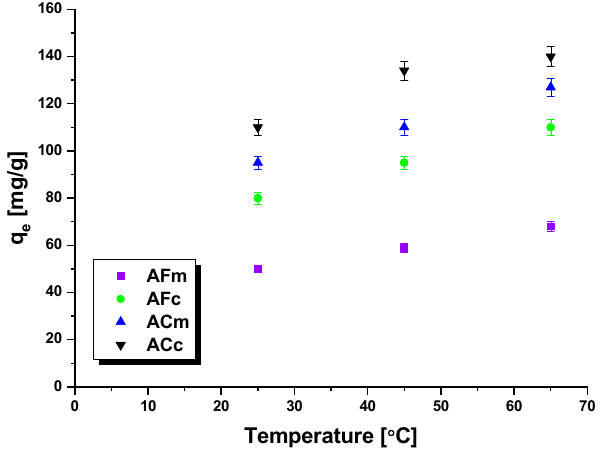
Figure 9. Effect of temperature on the adsorption of methyl red sodium salt onto biocarbons.